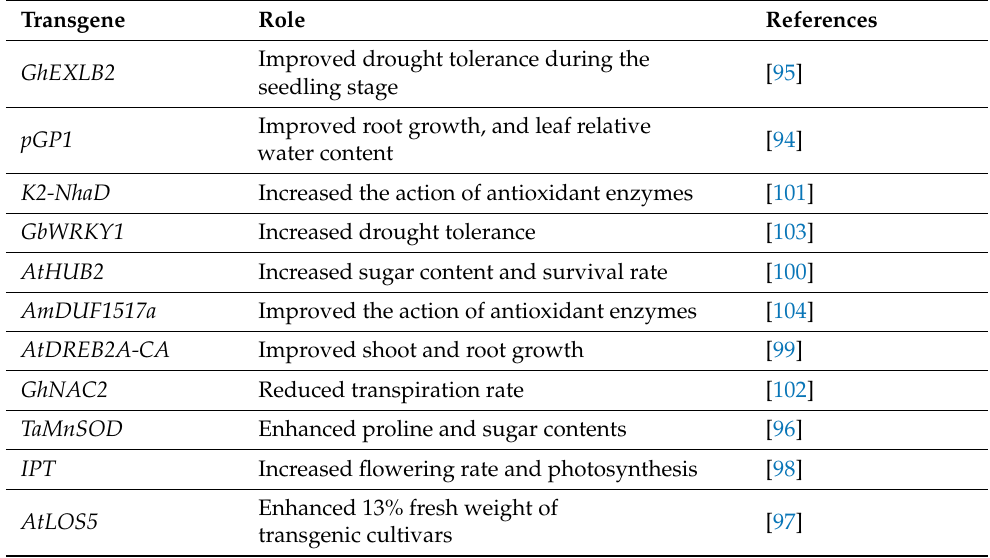
Table 5. Role of genetic engineering in the improvement of drought tolerance in